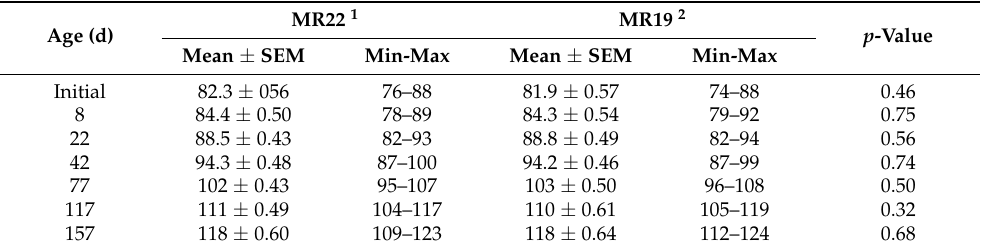
Figure 1. Growth performance represented as means and standard error bars of ( a ) BW (body weight) and ( b ) ADG (average daily gain) of calves fed with milk replacer content 22% CP (MR22; n = 35) or 19% CP (MR19; n = 33), according to time periods. Table 4. Sacral Height (mean ± SEM; min-max) of groups MR22 and MR19 depending on age (d), given in